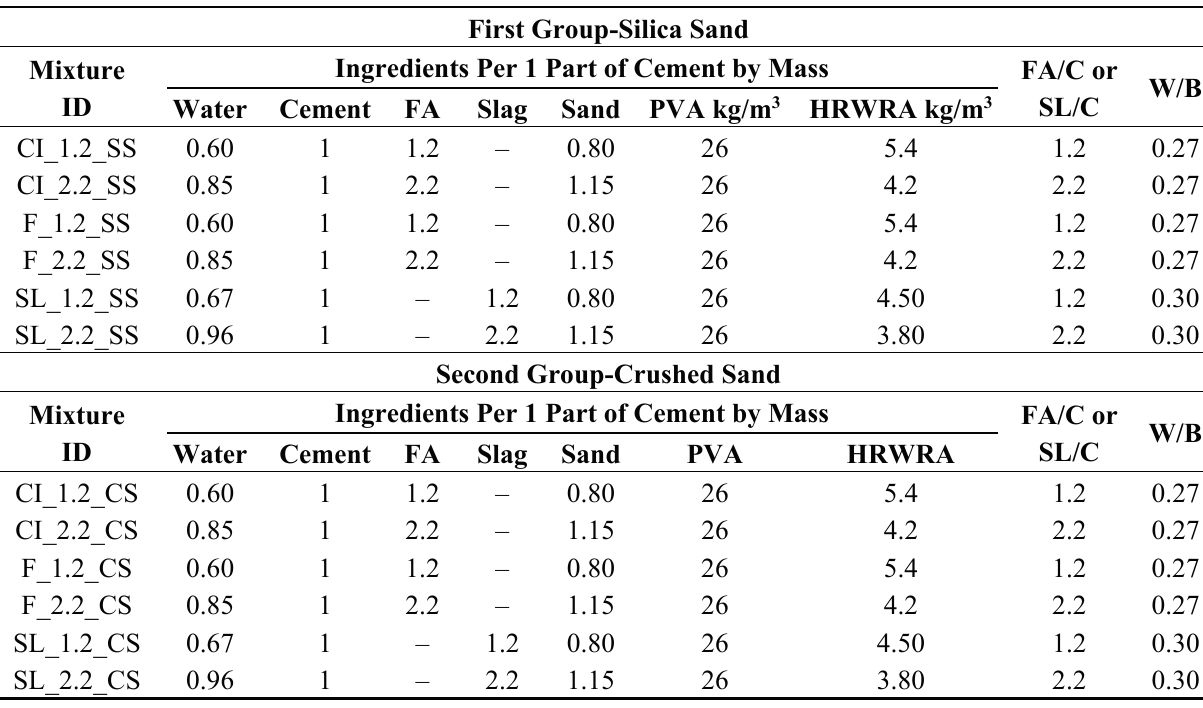
Table 3. Engineered cementitious composites (ECC) Mixture